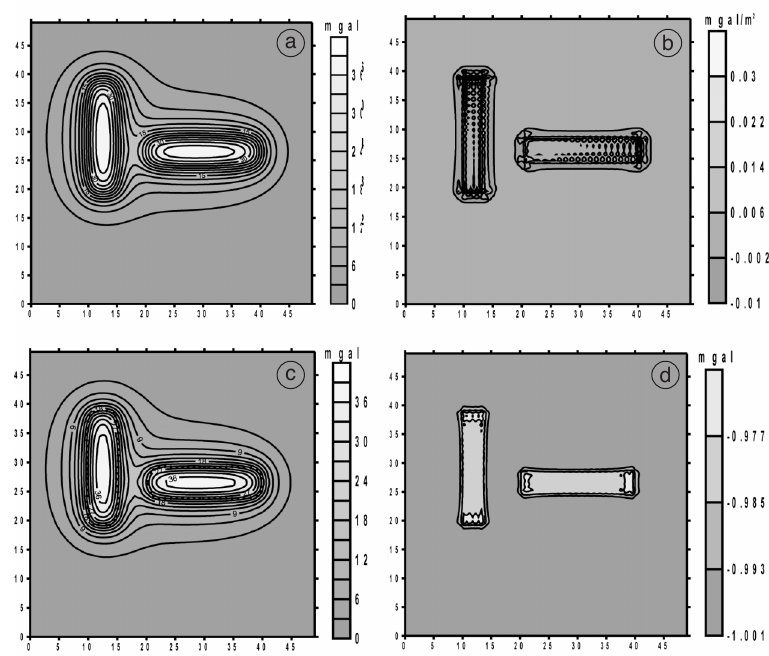
Fig. 4a-d. Two perpendicular prism model: a) gravity anomaly map (contour interval is 3 mgal); b) second ver- tical derivative map (contour interval is 0.008 mgal/m 2 ); c) boundry analysis output (contour interval is 3 mgal); d) CNN output (contour interval is 0.008